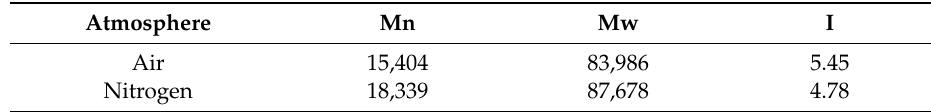
Table 2. Gel permeation chromatography ( GPC) results for EBA copolymer with air atmosphere and N 2 .